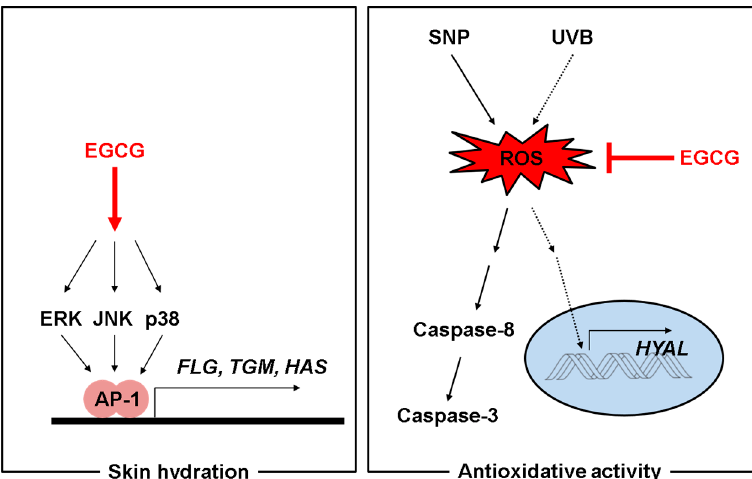
Figure 5. Mechanisms of skin hydrating and antioxidant activities of EGCG. EGCG upregulated expression of skin hydrating genes in HaCaT cells. EGCG possessed antioxidative ability and cleared the radicals from SNP and UVB. It also inhibited activation of caspases-8 and -3, and expression of HYALs. Red arrow: Activation pathway by EGCG, and red line: Inhibition pathway by EGCG.